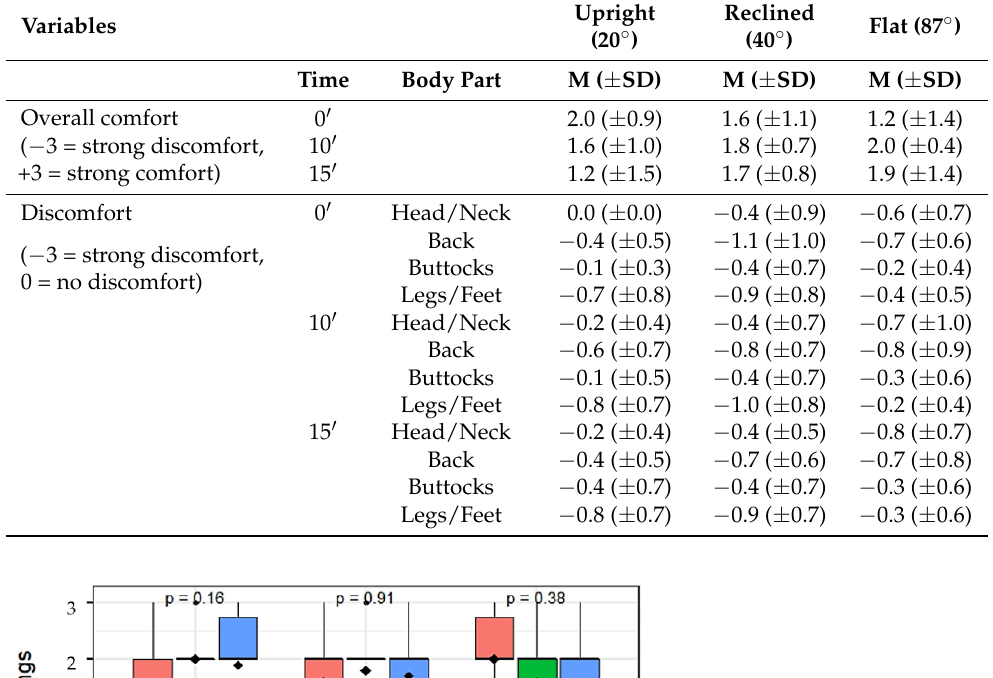
Table 1. Measures for the comfort and discomfort perceptions for the upright, reclined and flat conditions.